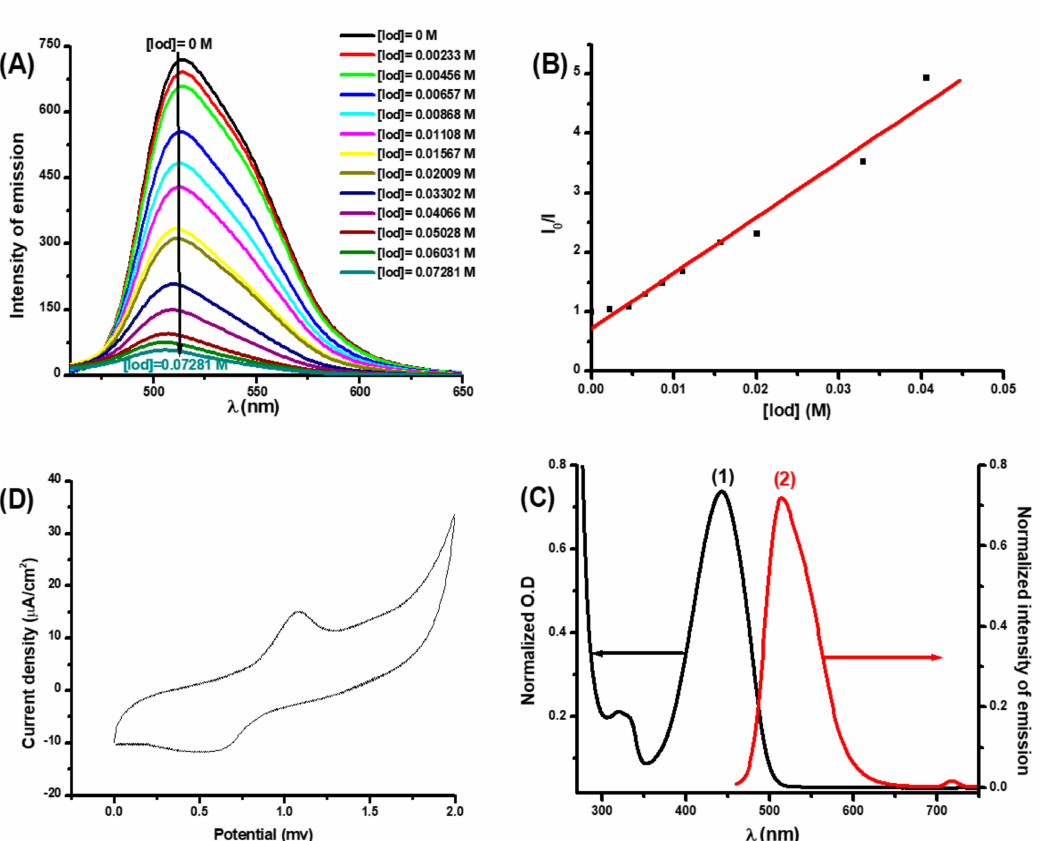
Figure 8. ( A ) Fluorescence quenching of Coum2 by Iod, ( B ) Determination of the Stern–Volmer coe ffi cient, ( C ) ES1 determination, and ( D ) Cyclic voltammetry of Coum2 in